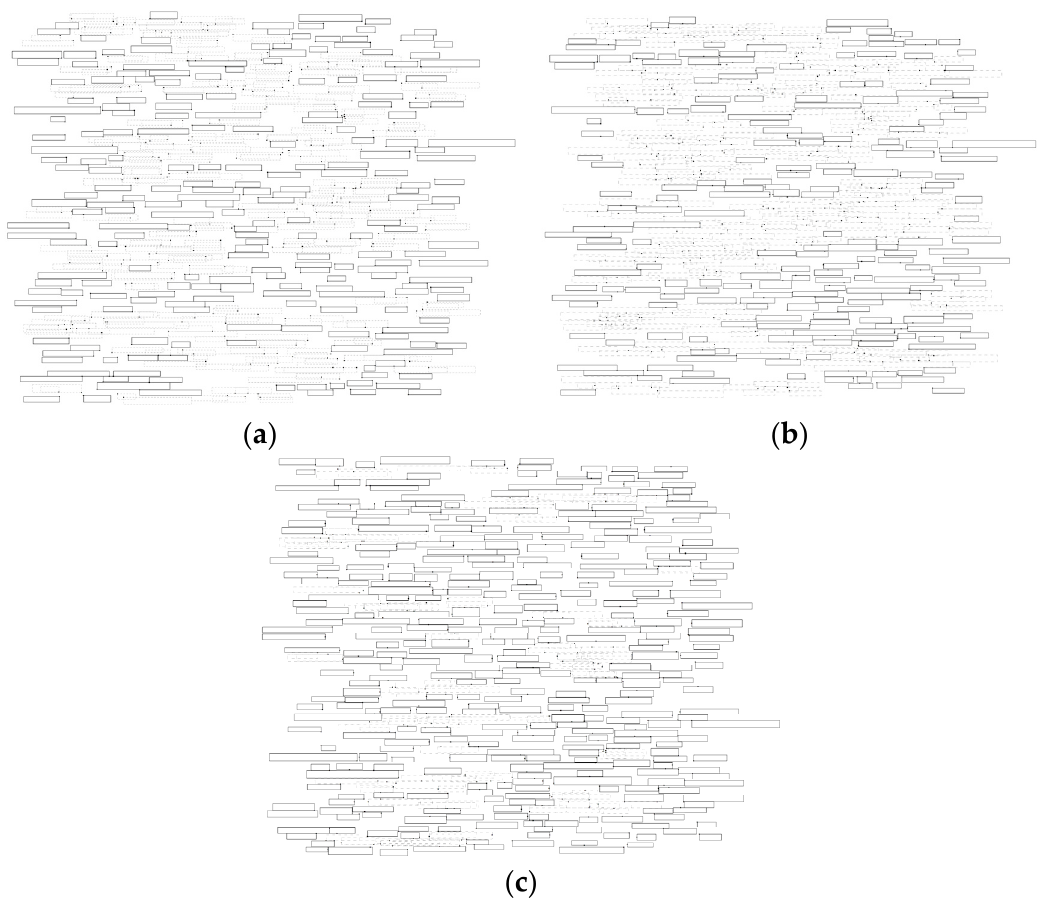
Figure 11. Labeling result for the RandomMap instance with 500 points. ( a ) Four-position model: 224 conflict-free labels; ( b ) four-slider model: 205 conflict-free labels; ( c ) the proposed model: 358 conflict-free labels.